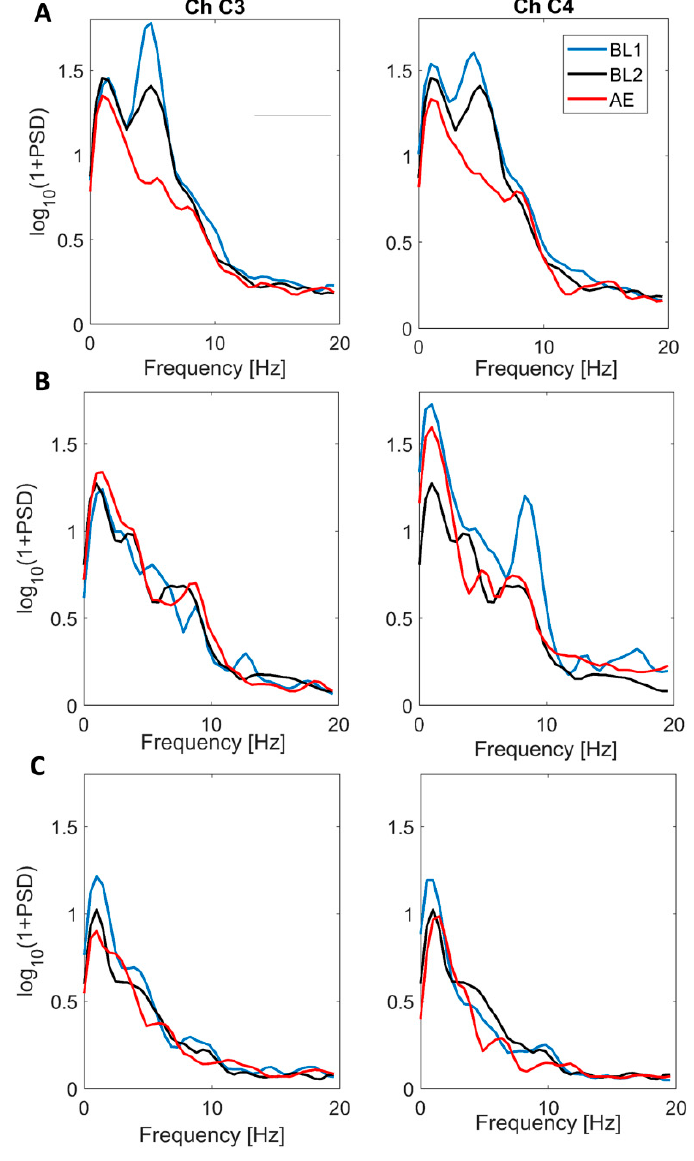
Figure 4. Power spectral density (PSD) estimated on two representative channels of the central clusters (channel 3, left column and channel 4, right column) during BL1 (blu), BL2 (black) and AE (red) for one subject of the Group 1 (Panel A ), one subject of Group 2 showing a mu-rhythm peak (Panel B ) and one subject of Group 2 that doesn’t have a clear mu-rhythm peak during baseline conditions (Panel C ).